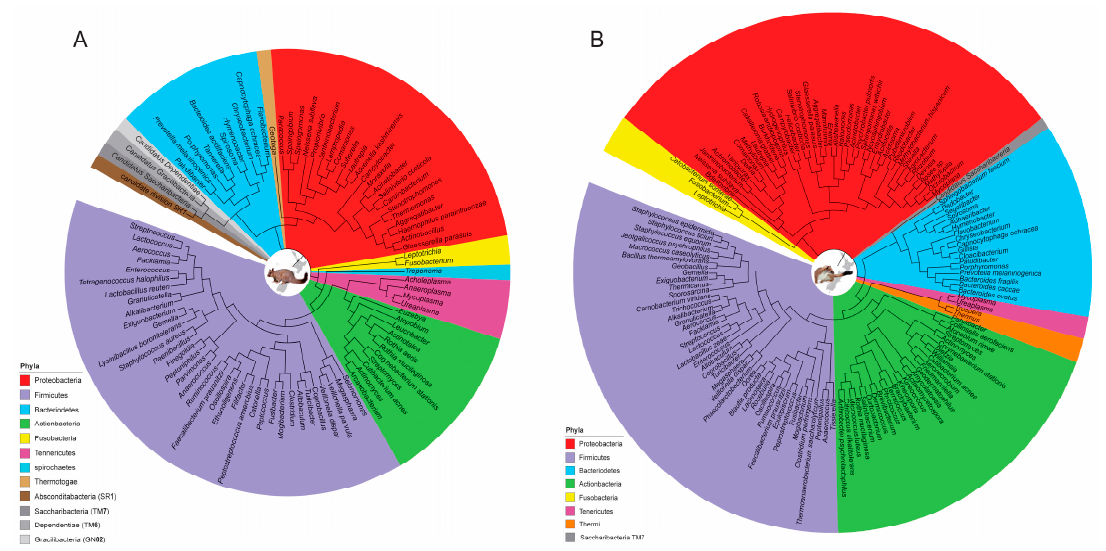
Figure 5. Phylogenetic trees showing bacterial taxa identified at the genus or species level identified from the oral cavities of ( A ) brushtail possums and ( B ) stoats. Colours represent different bacterial phyla.